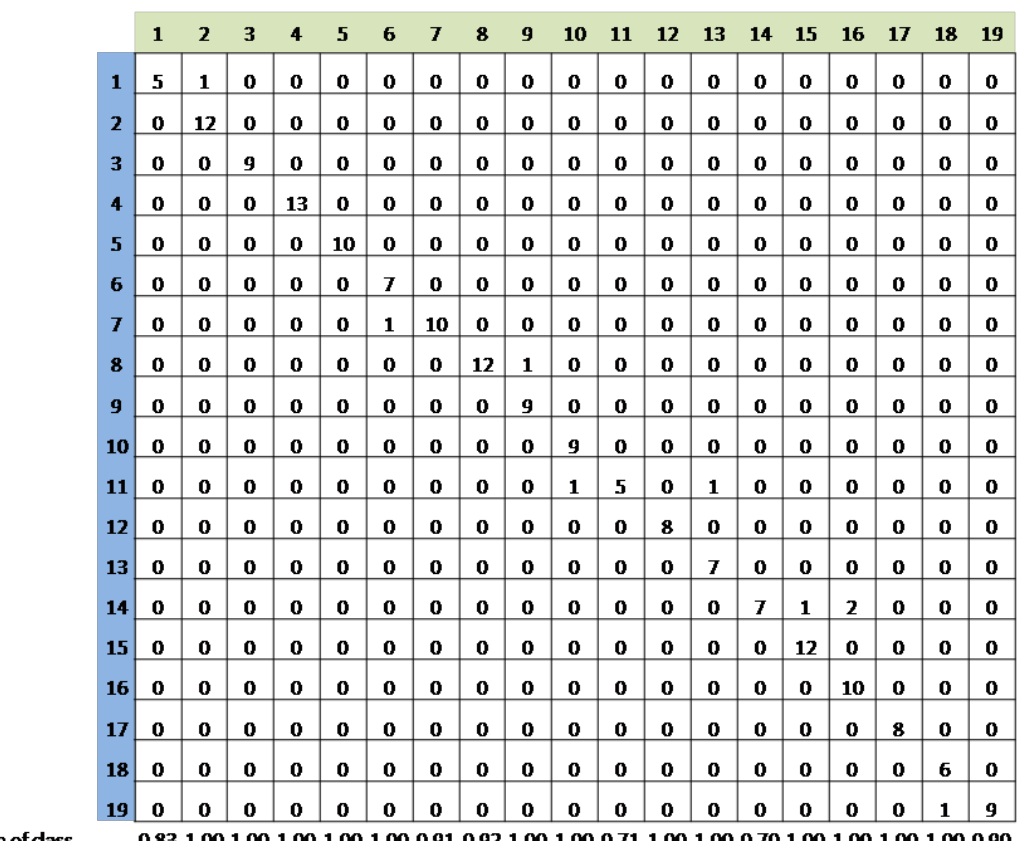
Fig. 3. The confusion matrix and precision of classes for test